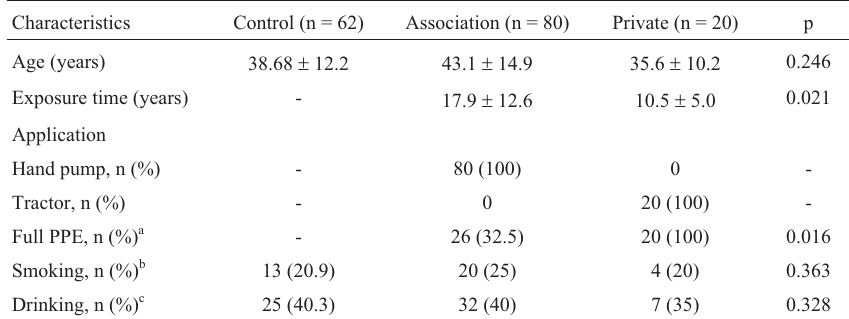
Table 1 - Characteristics of the study